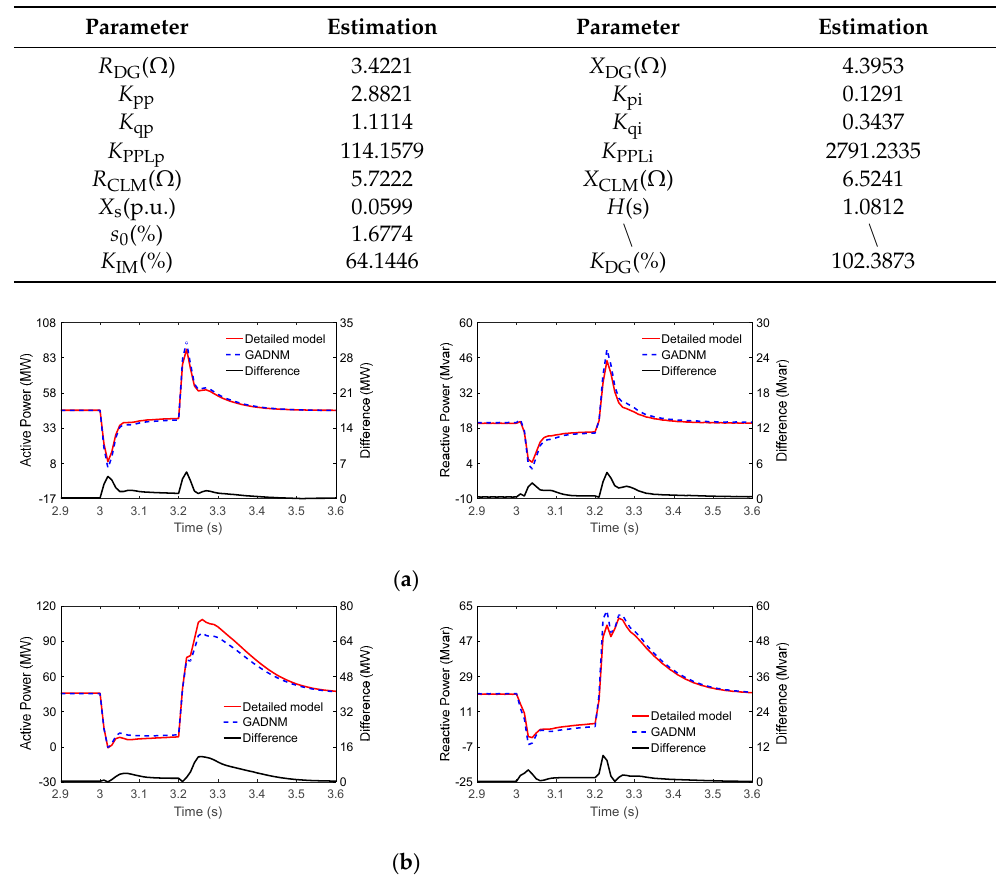
Figure 11. Responses of the two voltage dip disturbances with K DG = 20%. ( a ) 20% U n voltage dip. ( b ) 70% U n voltage